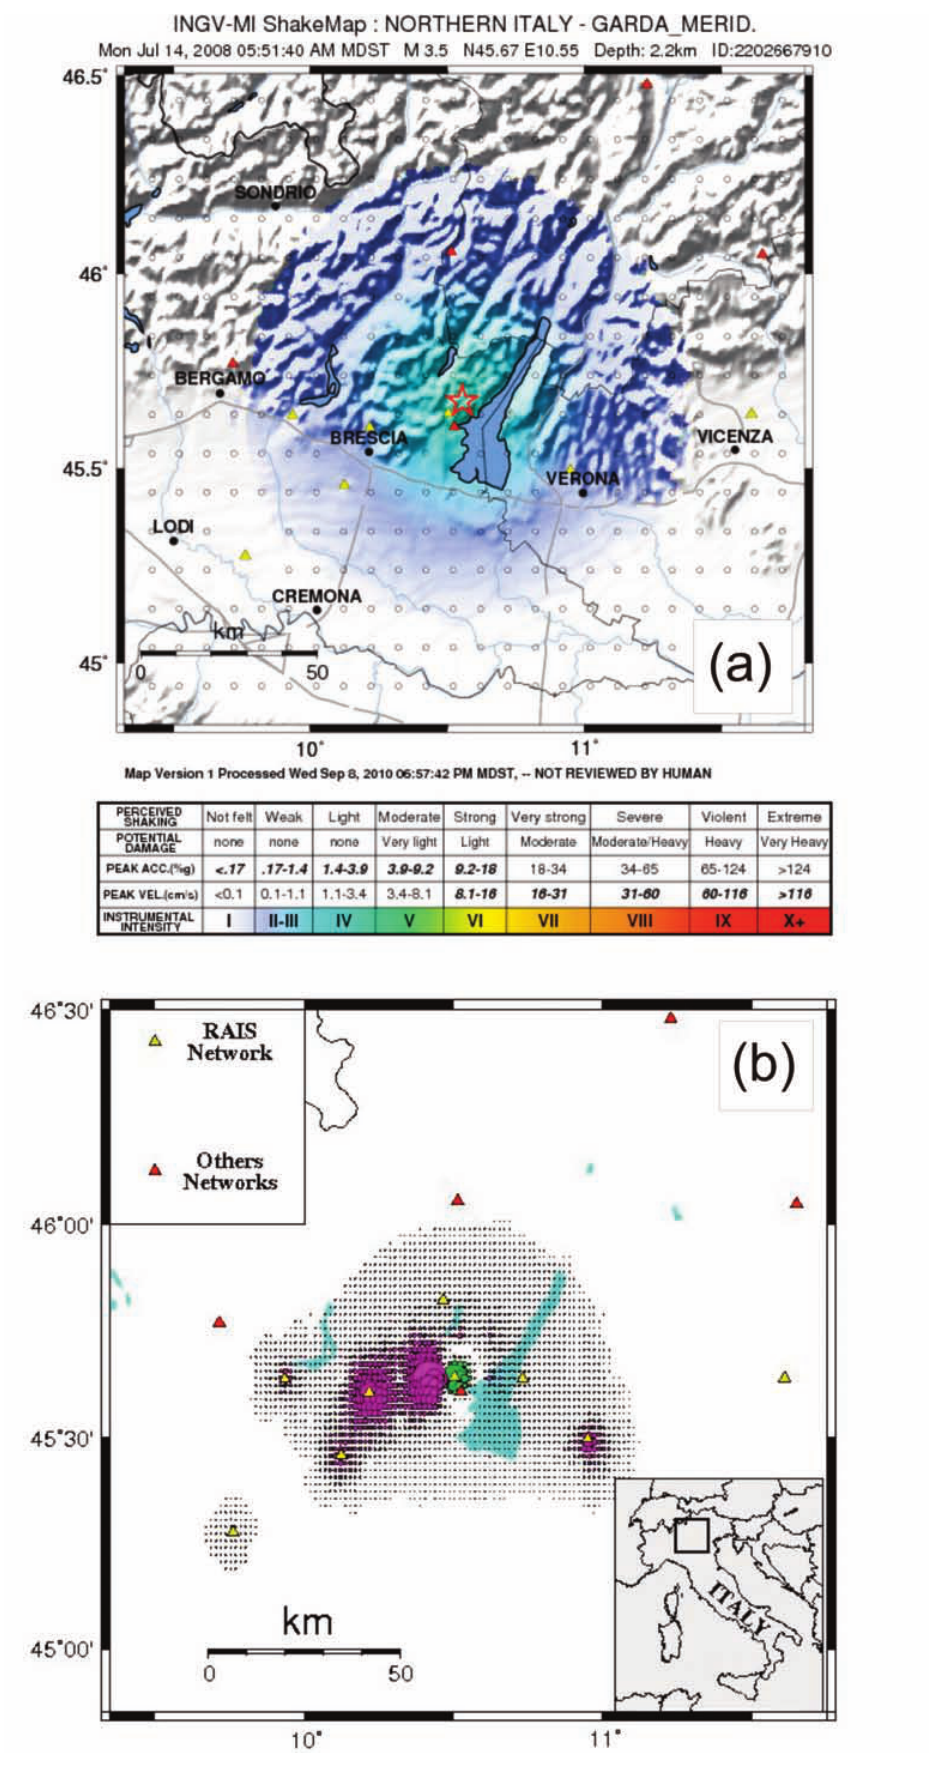
Figure 8. (a) Shake map of July 14, 2008, M 3.5, Garda earthquake for instrumental intensity. Star, epicenter location. (b) PGA residuals obtained with and without considering the RAIS stations. Yellow triangles, RAIS stations; Red triangles, other